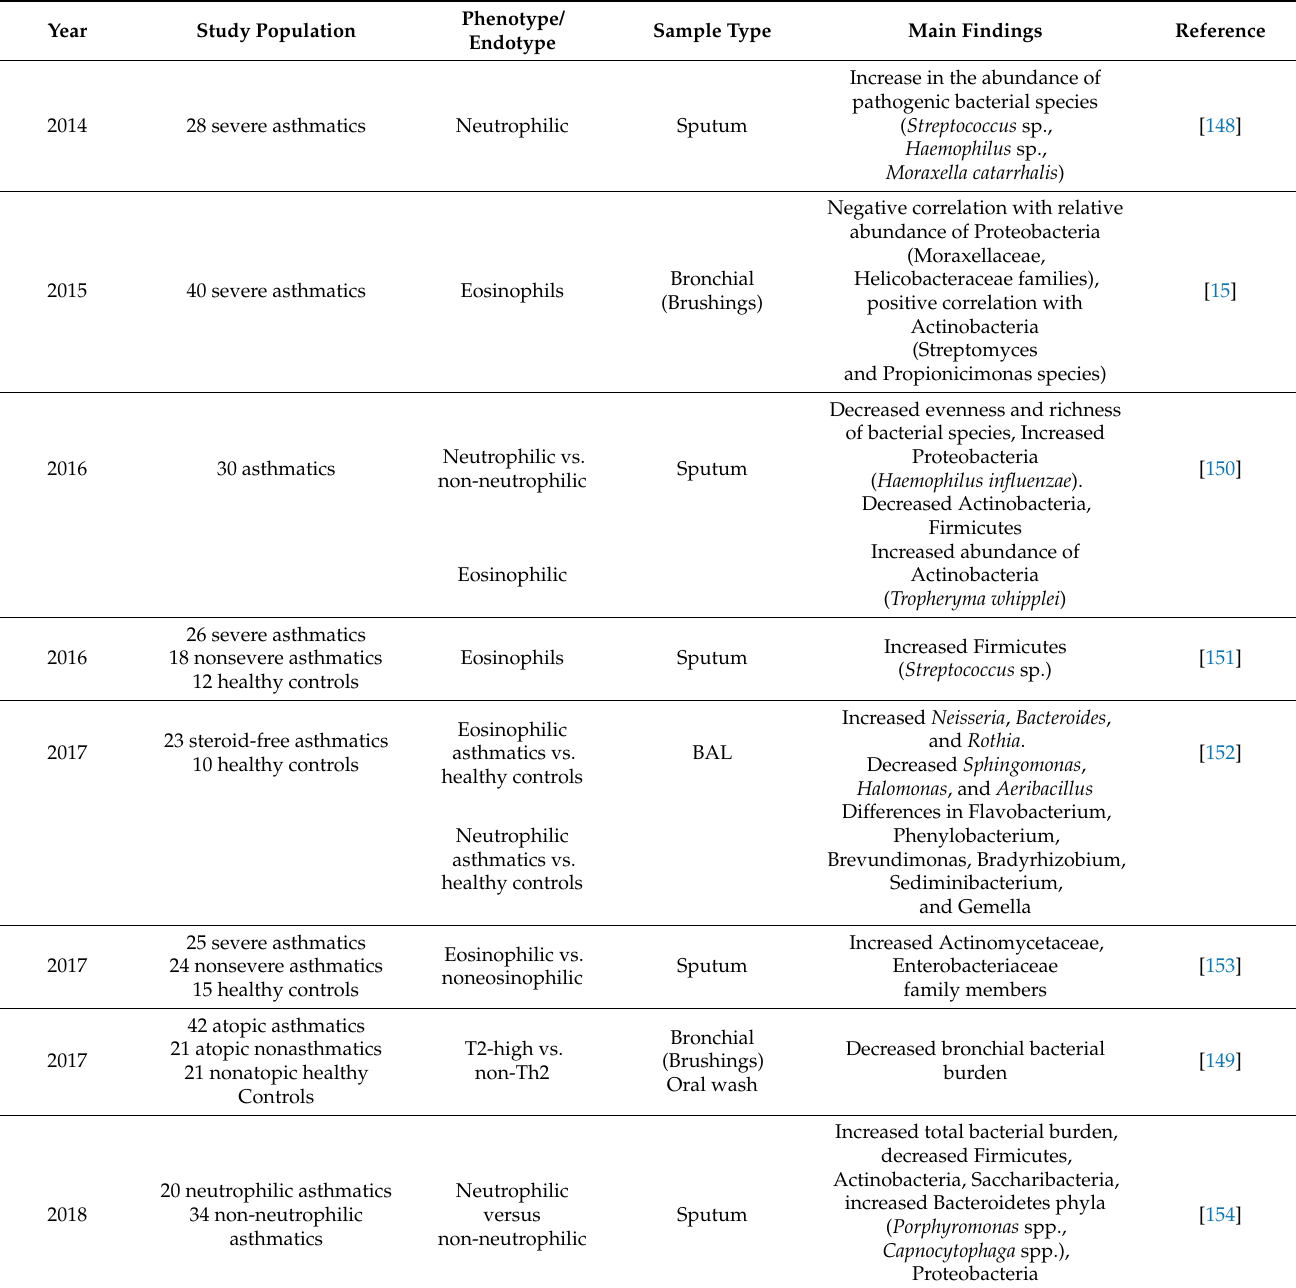
Table 3. Summary of the published studies related to the respiratory microbiome in asthma